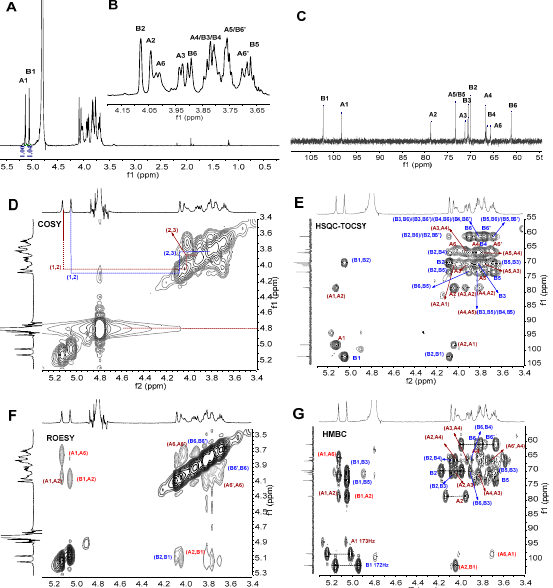
Figure 2. 1 H ( A , B ), 13 C ( C ), COSY ( D ), HSQC-TOCSY ( E ), ROESY ( F ), HMBC ( G ) NMR spectra of BCG-1. Chemical shifts are relative to internal trimethylsilylpropionic acid sodium at 0 ppm. The letters A (maroon) and B (blue) represented 2,6- O - α -Man p (Residue A) and t- α -Man p (Residue B), respectively.